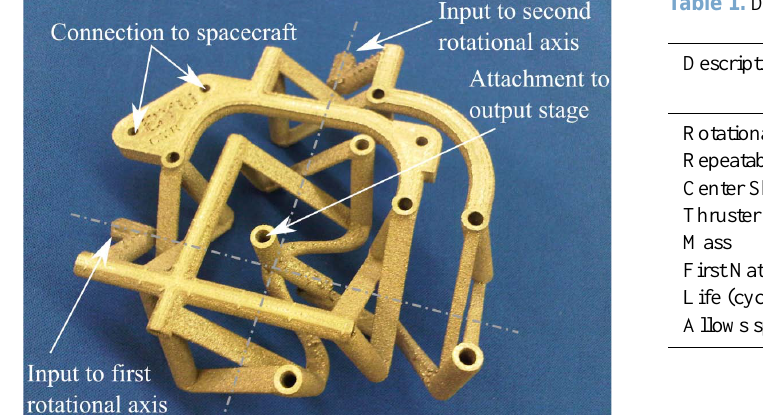
Table 1. Design objectives of space